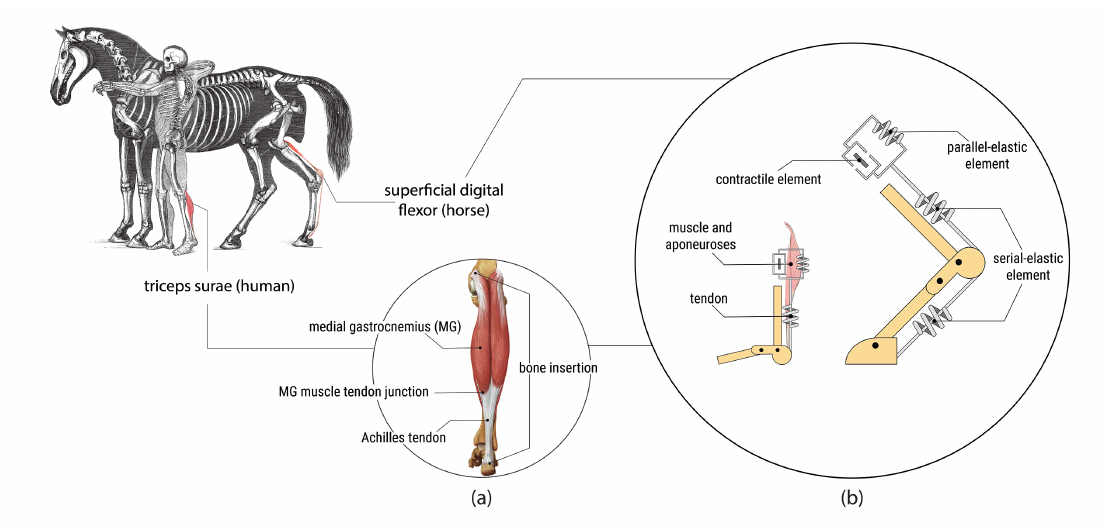
Figure 1. Components and modelling of Hill-type muscle–tendon units (MTUs) in humans and horses: ( a ) shows the human plantarflexor triceps surae (TS) and the components and landmarks of the medial gastrocnemius (MG) MTU; ( b ) shows a simple modeling approach [12] of the human MG MTU and the equine superficial digital flexor (SFDF) MTU [11]. An alignment of elastic springs and contractile elements is used to model the functions of muscles (active) and tendons